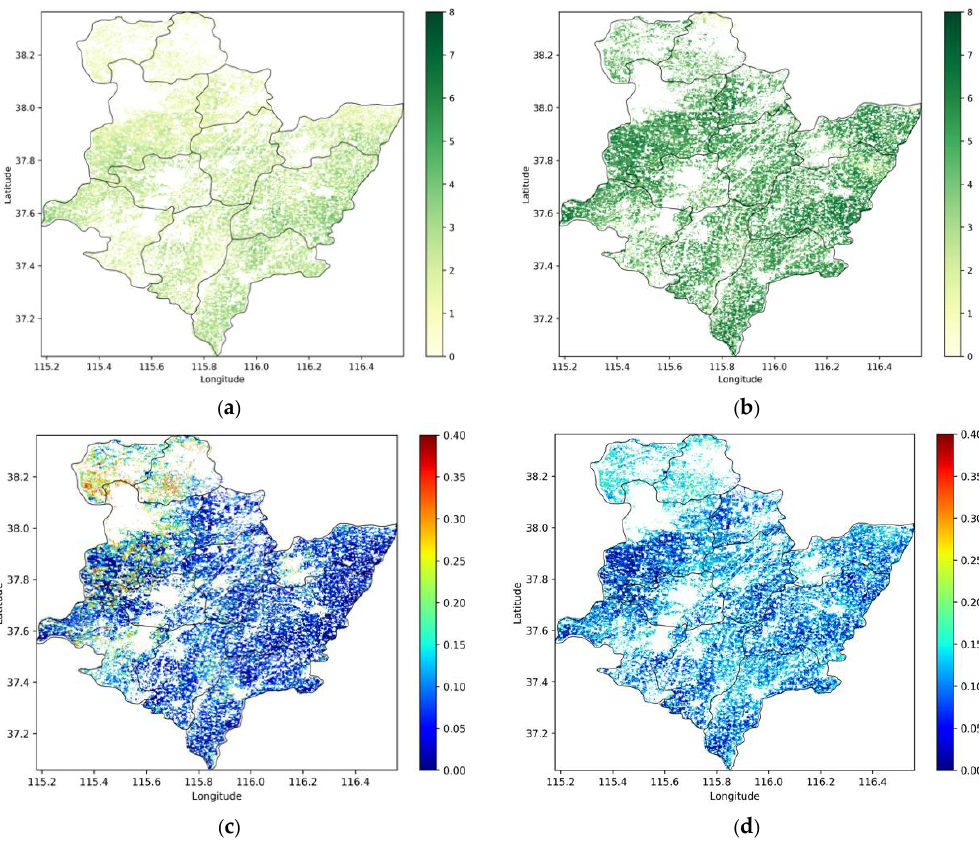
Figure 4. Retrieved LAI and SM maps obtained at two key phenological stages (green-up: ( a , c ); and jointing: ( b , d )) of winter wheat area in the city of Hengshui. ( a ) Retrieved LAI 29 March 2017. ( b ) Retrieved LAI 28 April 2017. ( c ) Retrieved SM 2 April 2017. ( d ) Retrieved SM 8 May 2017.